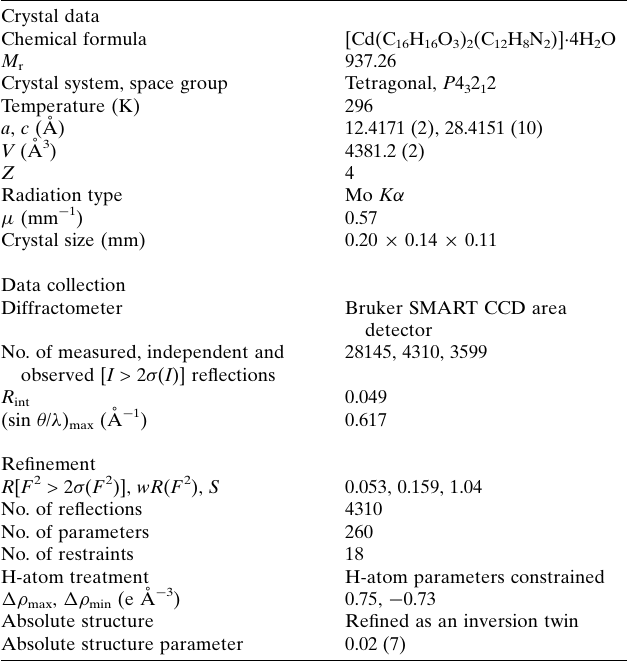
Table 4 Experimental details. Crystal data Chemical